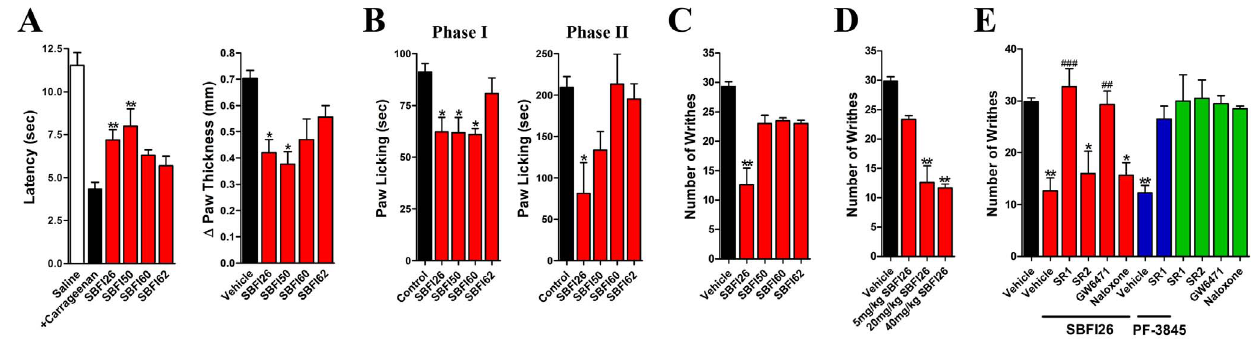
Figure 2. FABP inhibitors reduce nociception in models of inflammatory and visceral pain. (A) Effects of SBFI26, SBFI50, SBFI60, and SBFI62 (20 mg/kg, i.p.) upon carrageenan-induced thermal hyperalgesia (left panel) and paw edema (right panel) in mice. *, p , 0.05; **, p , 0.01 versus carrageenan injected animals (black bar) (n=6). (B) Effect of FABP inhibitors (20 mg/kg, i.p.) upon the first (left panel) and second phases (right panel) of formalin-induced nociception in mice. *, p , 0.05 versus vehicle control (n=6). (C) SBFI26 reduces acetic acid-induced writhing in mice. **, p , 0.01 (n=6). (D) Dose-response of SBFI26-mediated inhibition of acetic acid writhing in mice. **, p , 0.01 (n=6). (E) The antinociceptive effects of SBFI26 are reversed by the cannabinoid receptor 1 antagonist rimonabant (SR1, 3 mg/kg) and the peroxisome proliferator-activated receptor alpha antagonist GW6471 (4 mg/kg). In contrast, the cannabinoid receptor 2 antagonist SR144518 (SR2, 3 mg/kg) and the opioid antagonist naloxone (2 mg/kg) were without effect. Rimonabant also reversed the antinociceptive effects of the FAAH inhibitor PF-3845 (blue bars). When administered alone, the antagonists did not modulate nociception (green bars). *, p , 0.05; **, p , 0.01 versus vehicle control. ## , p , 0.01; ### , p , 0.001 versus SBFI26 treated mice (n=6–9).